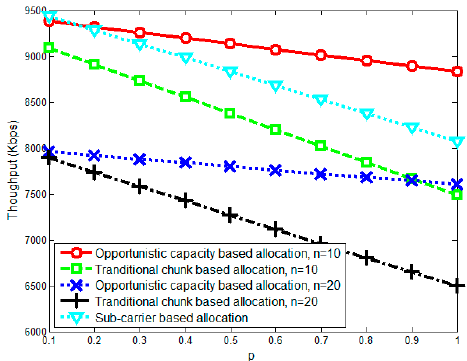
Figure 4. Average throughput with different chunk capacity change rates p .